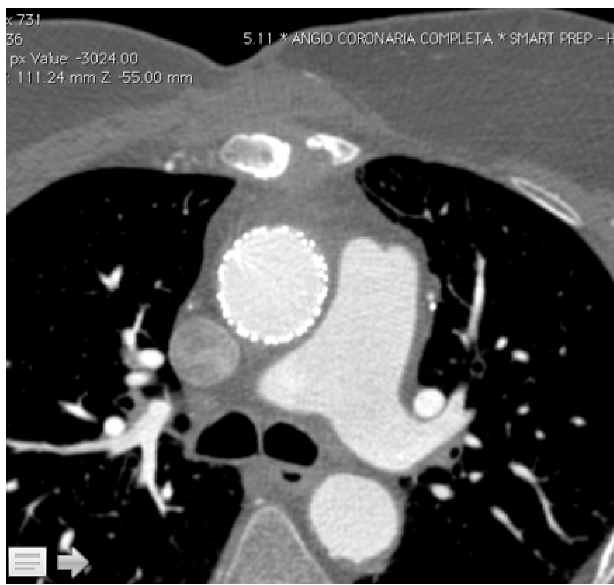
Fig. 2 – Computed tomography, axial view, post stent graft in ascending aorta.